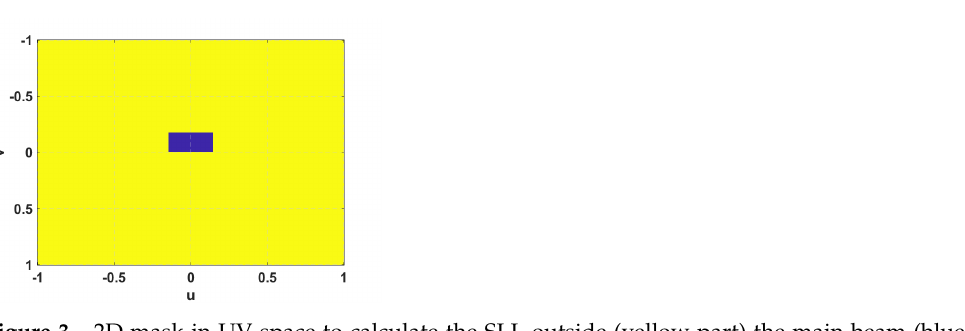
Figure 3. 2D mask in UV space to calculate the SLL outside (yellow part) the main beam (blue part) area.